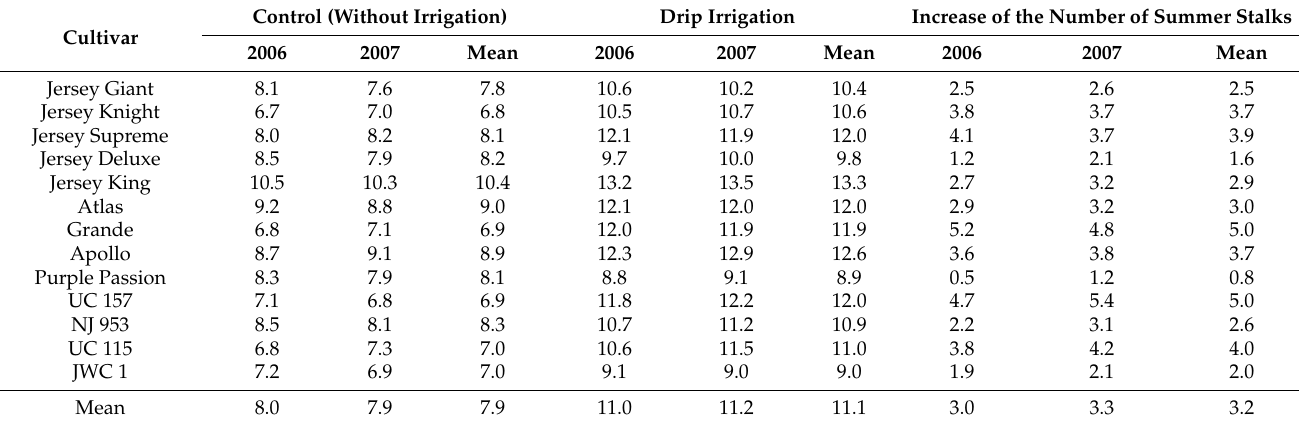
Table 8. Number of the asparagus summer stalks (pcs) as dependent on cultivar and irrigation. Control (Without Irrigation) Drip Irrigation Increase of the Number of Summer Cultivar